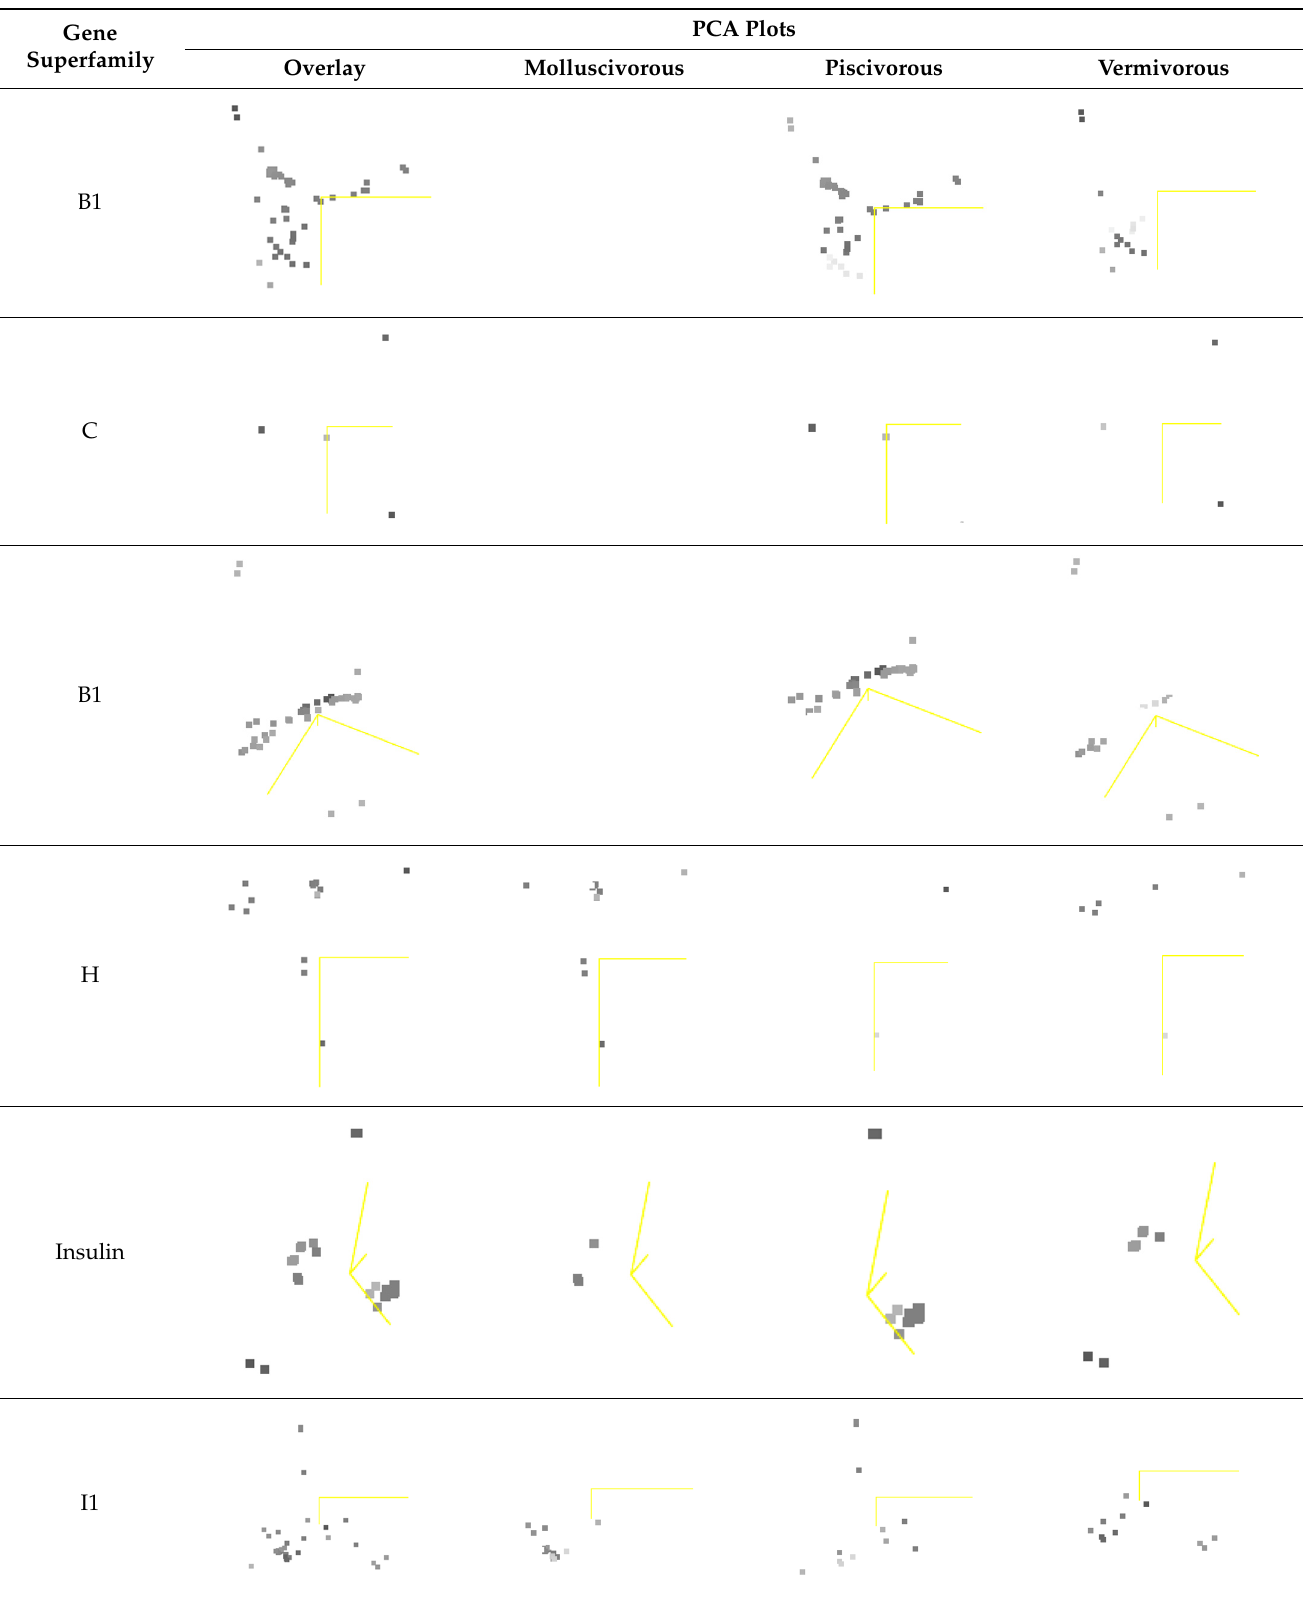
Table A1. Principal component analysis plots.